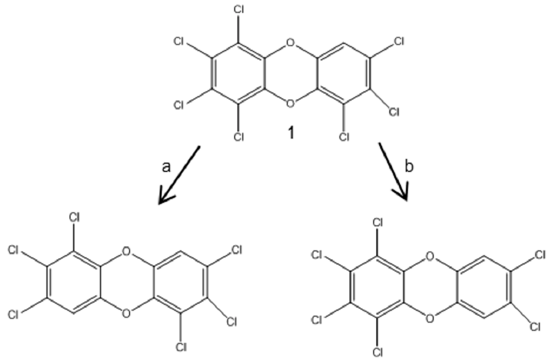
Figure 8. Proposed dechlorination of 1,2,3,4,6,7,8-HeCDF ( 1 ) from aquifer microcosms [38]. The major dechlorination pathway is ( a ); and the minor is ( b ).